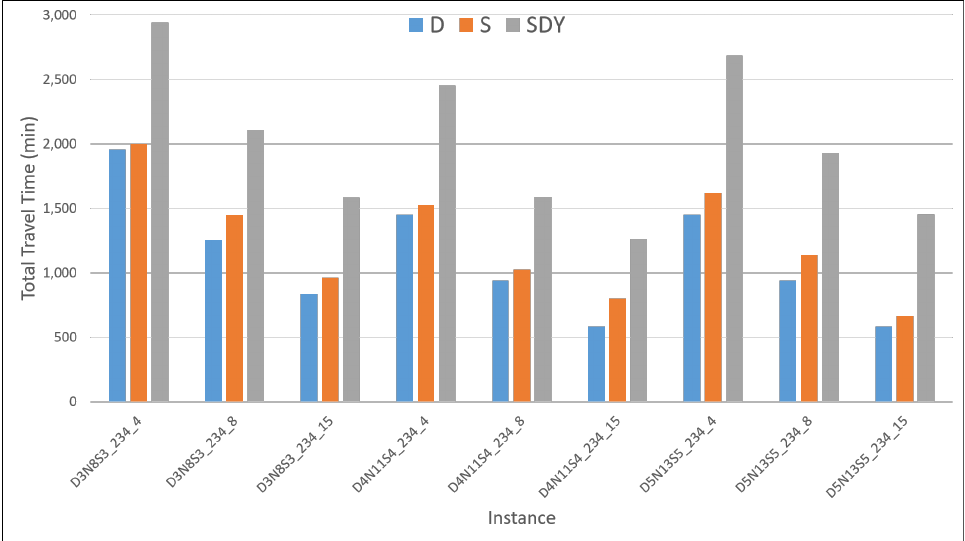
Figure A8. Total Travel Time for Maximum Road Capacity Setting ( 2,3,4 ) : Offline and Online Computation for all Instances based on Model